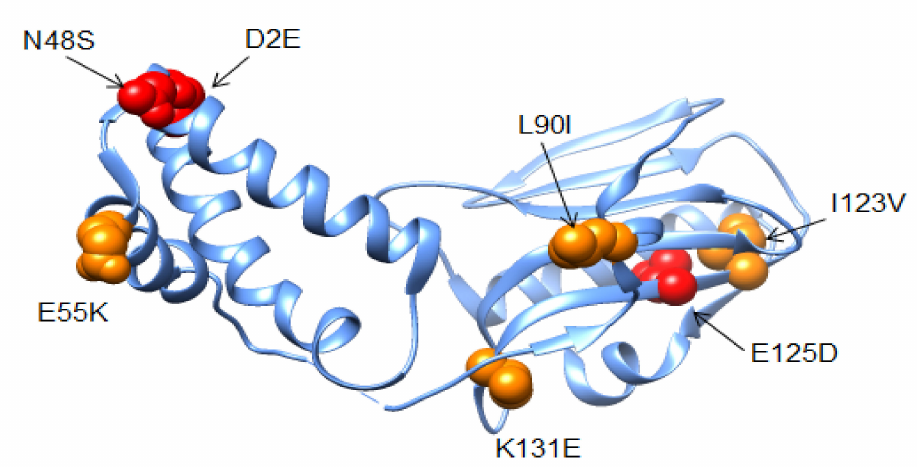
Figure 8. 3D structure of NS1 molecule with changes in the Ukrainian isolates (PDB ID—3F5T). New mutations of NS1 of A(H1N1)pdm09 are shown in red.